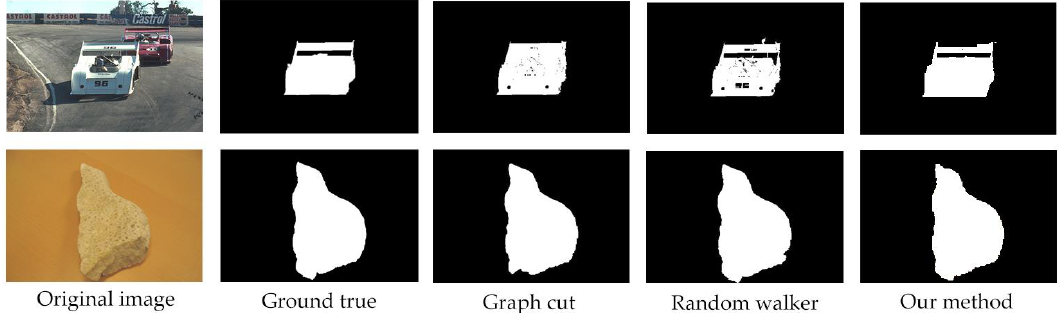
Figure 11. The evaluation on different algorithms.